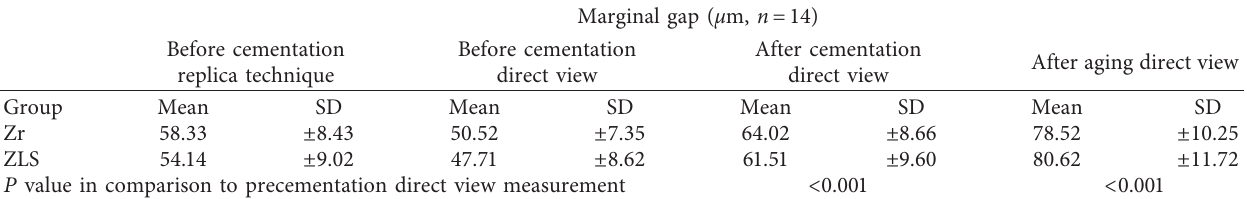
Table 3: Mean marginal gaps and standard deviations before cementation (replica and direct view technique), after cementation, and after thermomechanical aging.